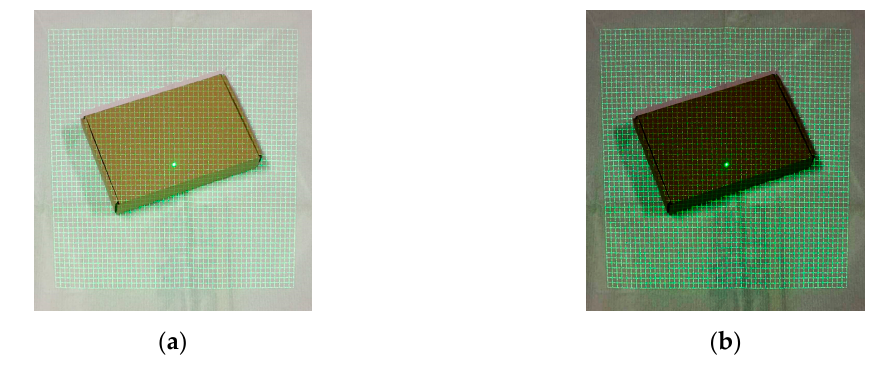
Figure 10. ( a ) The original image; ( b ) gamma transform corrected